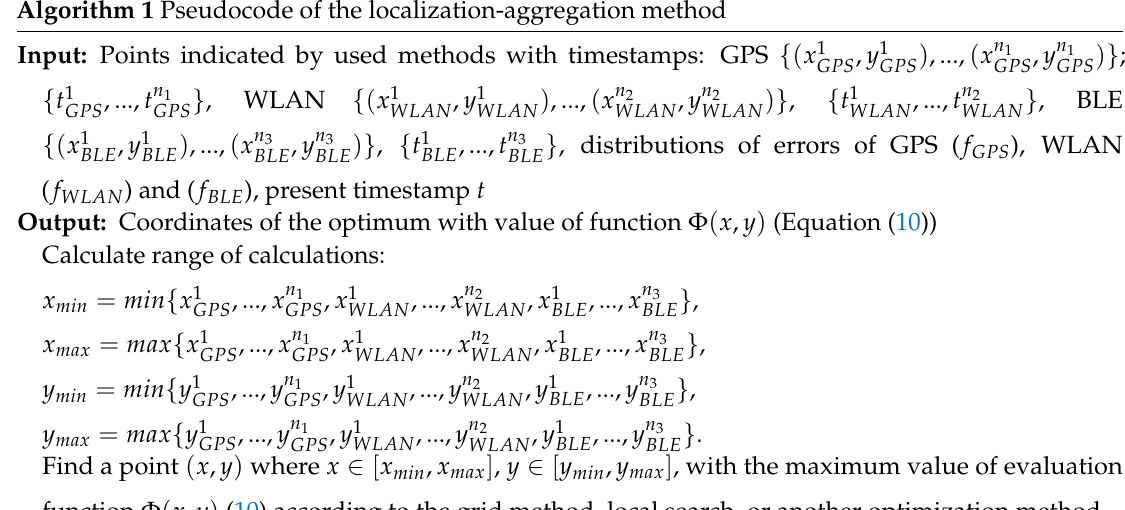
Algorithm 1 Pseudocode of the localization-aggregation